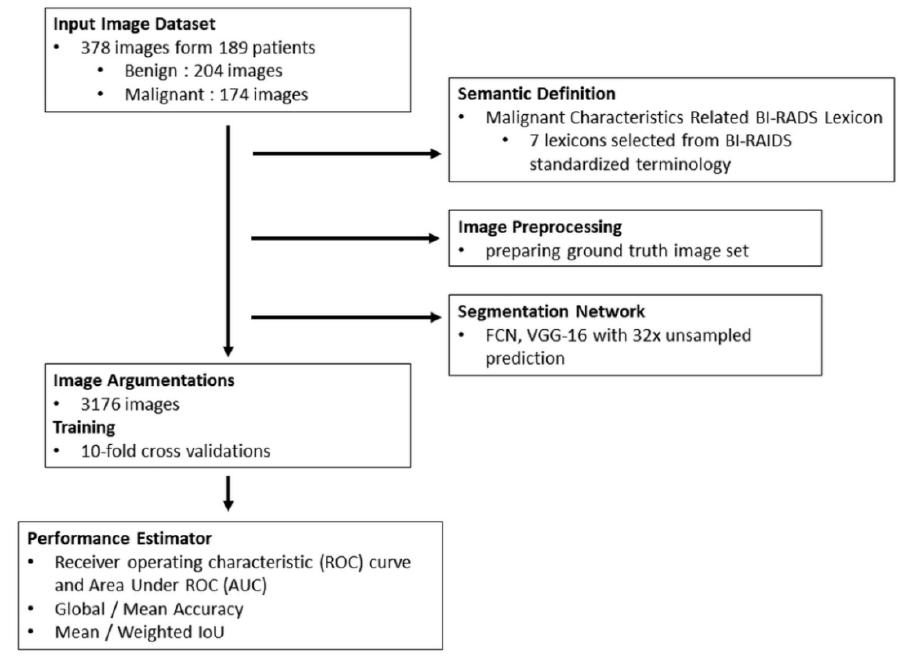
Figure 1. Study flowchart.